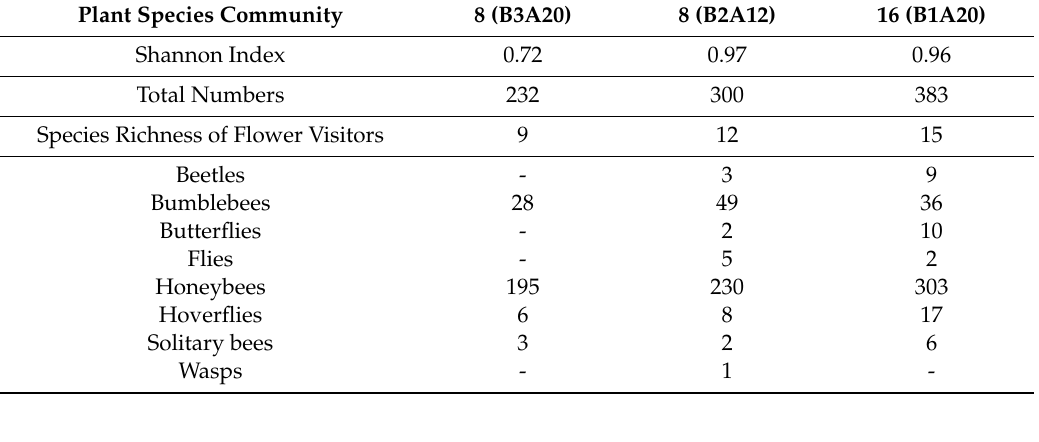
Table 2. Shannon diversity index [62], total numbers, species richness of flower visitors, number of individuals per flower-visiting guild of K. arvensis growing in plant species communities of eight and 16 plant species.